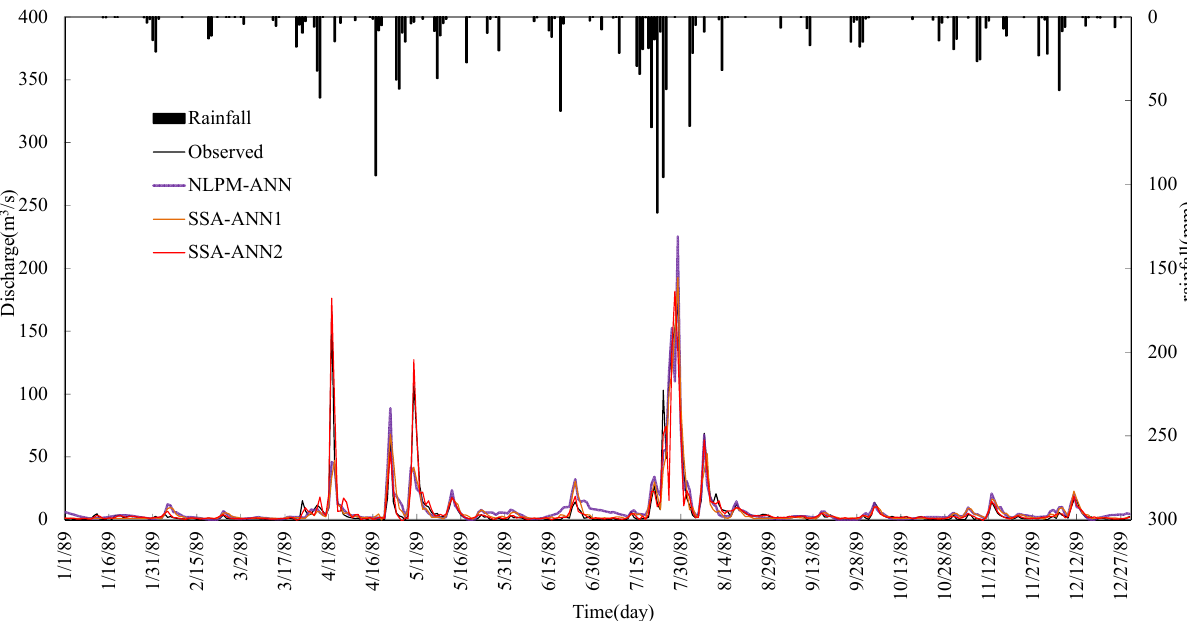
Figure 8. Observed and simulated runoff hydrographs by three models for Baohe.